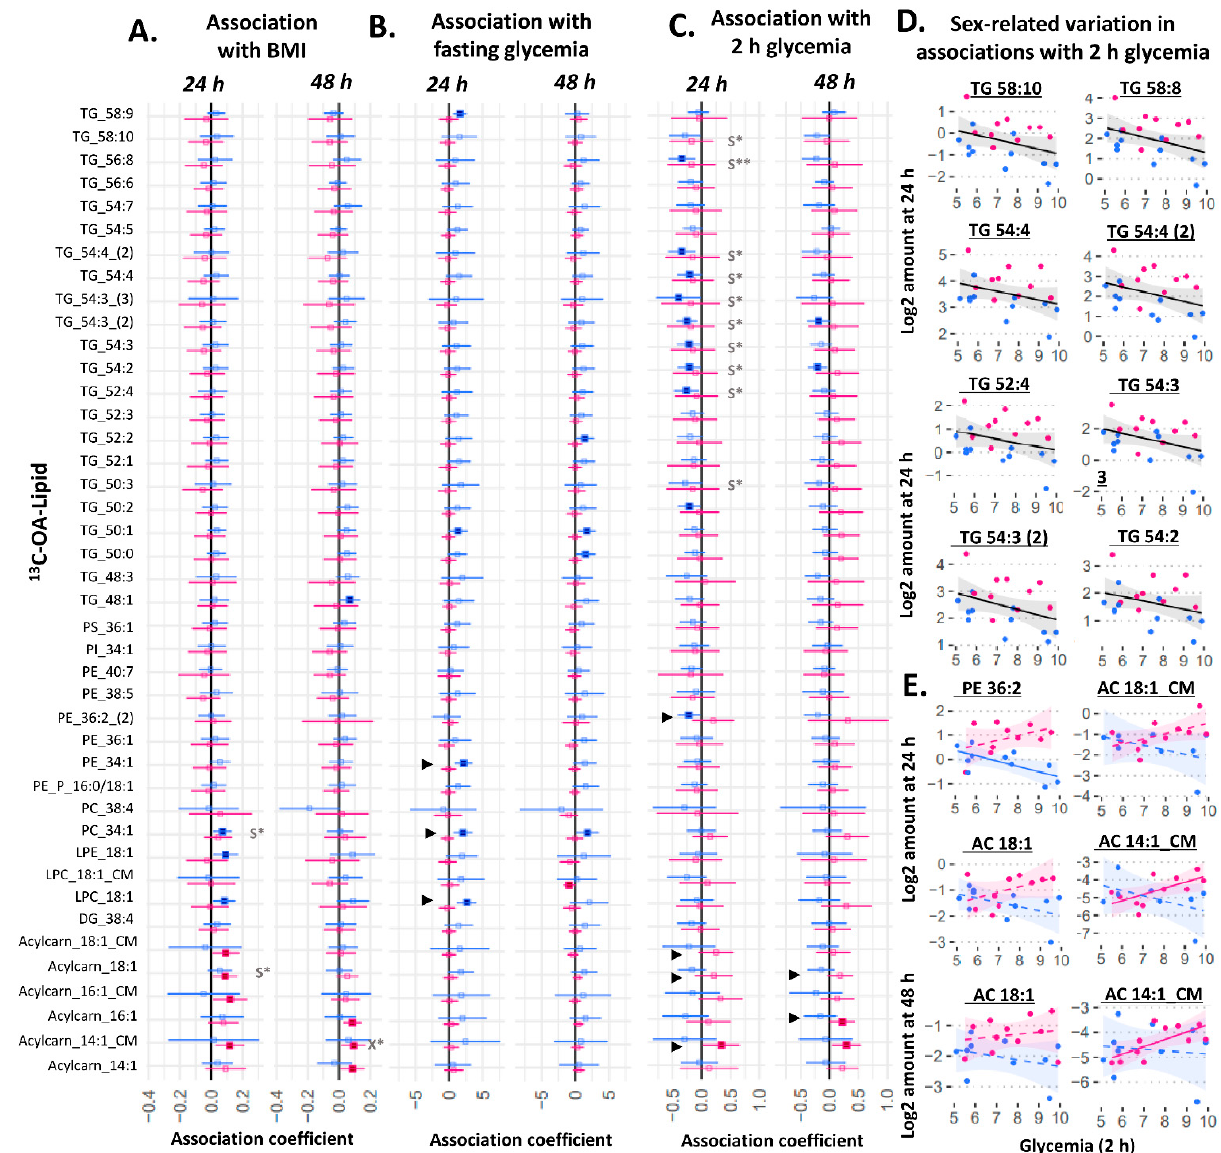
Figure 3. Sex-stratified associations between the amount of 13 C-OA lipid (outcome) and maternal glycemia or maternal BMI (predictor). X* represents p < 0.05 in linear regression with males and females combined (not shown). S* represents p < 0.05, while S** represents p < 0.01 in linear regression adjusted for sex (not shown). (cid:73) represents significant p < 0.05 for the interaction between sex and maternal glycemia on lipid amount. Linear regression was then run separately for males and females. Forest plots ( A – C ) show association coefficient and 95% confidence intervals for males (blue) and females (red) with significance ( p < 0.05) shown by dark-colored filled squares. Unadjusted scatter plots illustrating examples of the relationship between 2 h glycemia and amount of lipid for ( D ) lipids where males and females show similar relationships and for ( E ) lipids where males and females show different relationships. The Benjamini–Hochberg method was used to correct for multiple